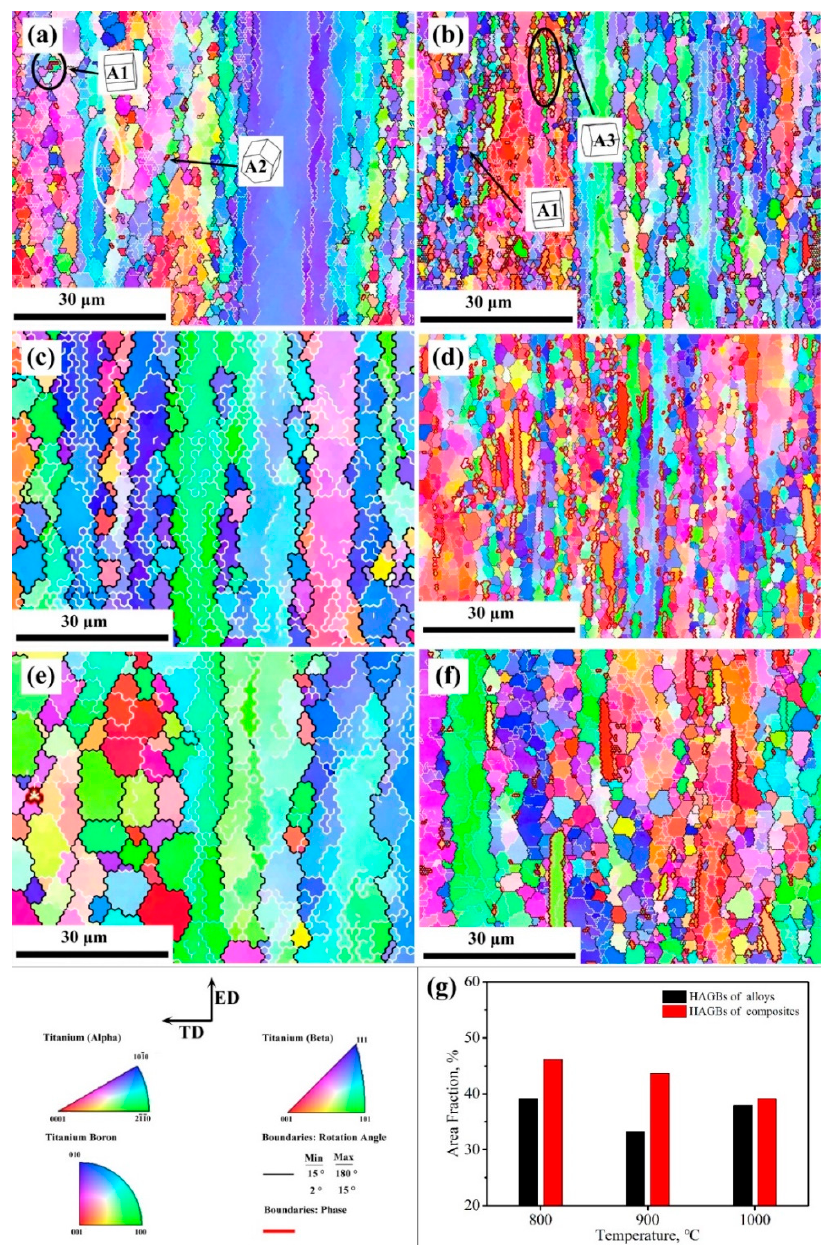
Figure 2. IPF mapping of alloys extruded at ( a ) 800 °C, ( c ) 900 °C, ( e ) 1000 °C and composites extruded at ( b ) 800 °C, ( d ) 900 °C, ( f ) 1000 °C; ( g ) histogram high-angle grain boundaries (HAGBs) counts of as-extruded alloys and composites.